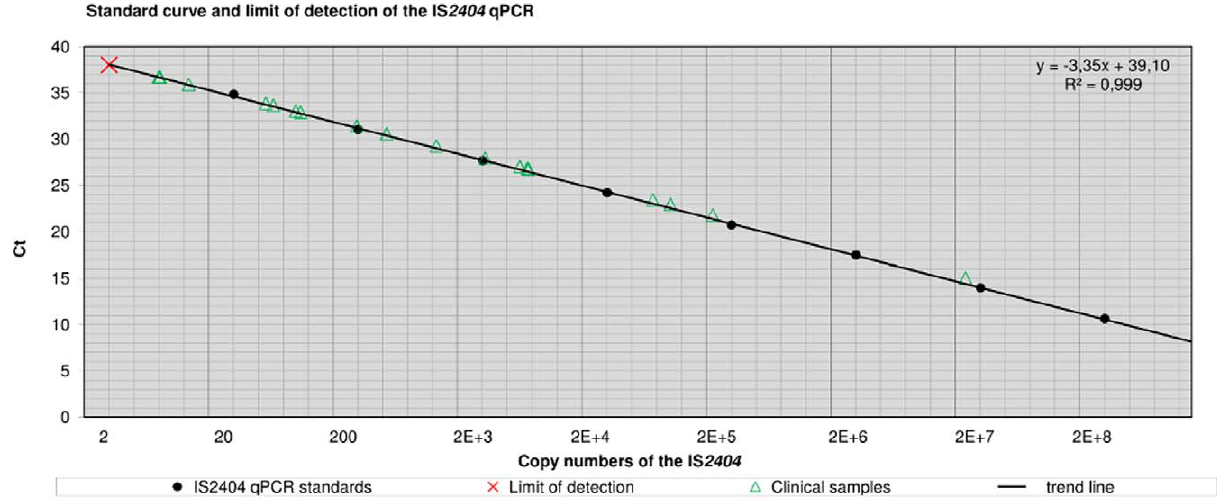
Figure 4. Standard curve and limit of detection of the IS 2404 qPCR. Figure 4 shows mean Ct-values of calibration standards and clinical samples plotted versus the quantified copy number of IS 2404 . Cloned IS 2404 templates were used as standards (Table 5). Log 10 fold serial dilutions ( n =8) were prepared ranging from 2E + 8 to 20 copies of the IS 2404 (PCR template: 2 m l) and were subjected to the IS 2404 qPCR in quadruplicate to generate a calibration curve. The regression line was y= 2 3.35x + 39.10 with a coefficient of correlation . 0.99 and the efficiency was E=0.97. The analytical sensitivity was determined as limit of detection (LOD) by subjecting 10 aliquots of a dilution series containing 10, 5, 4, 3, 2, or 1 copy of the IS 2404 to the assay. The LOD was 2 copies of the target sequence.